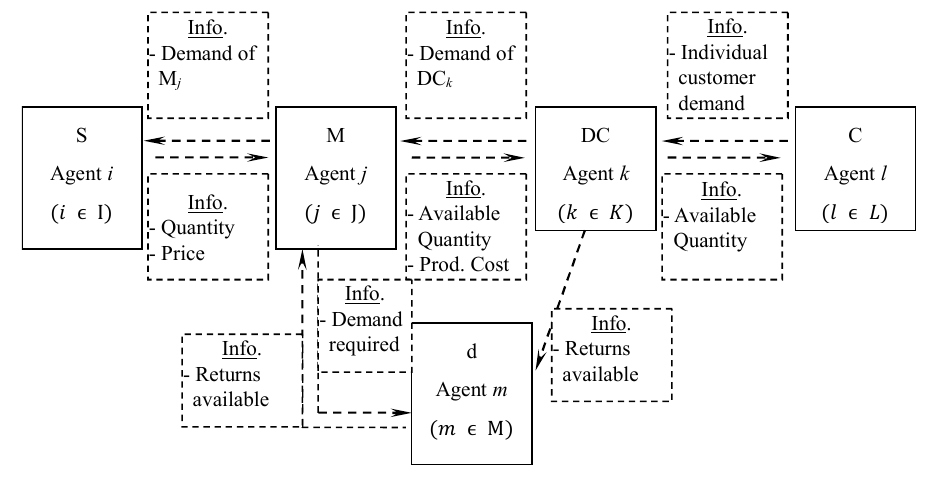
Figure 2. Outline of multi-agent based CLSC modeling.